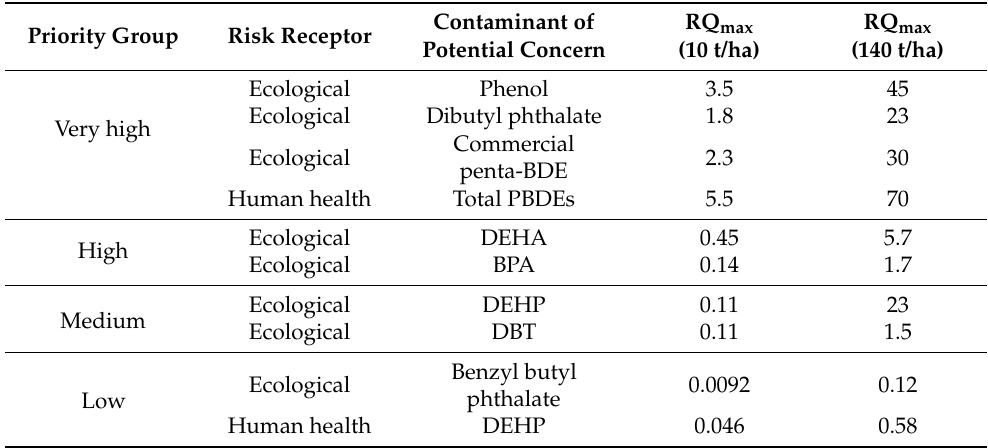
Table 2. Prioritization of selected contaminants based on the risk assessment conducted by Lang- don et al.